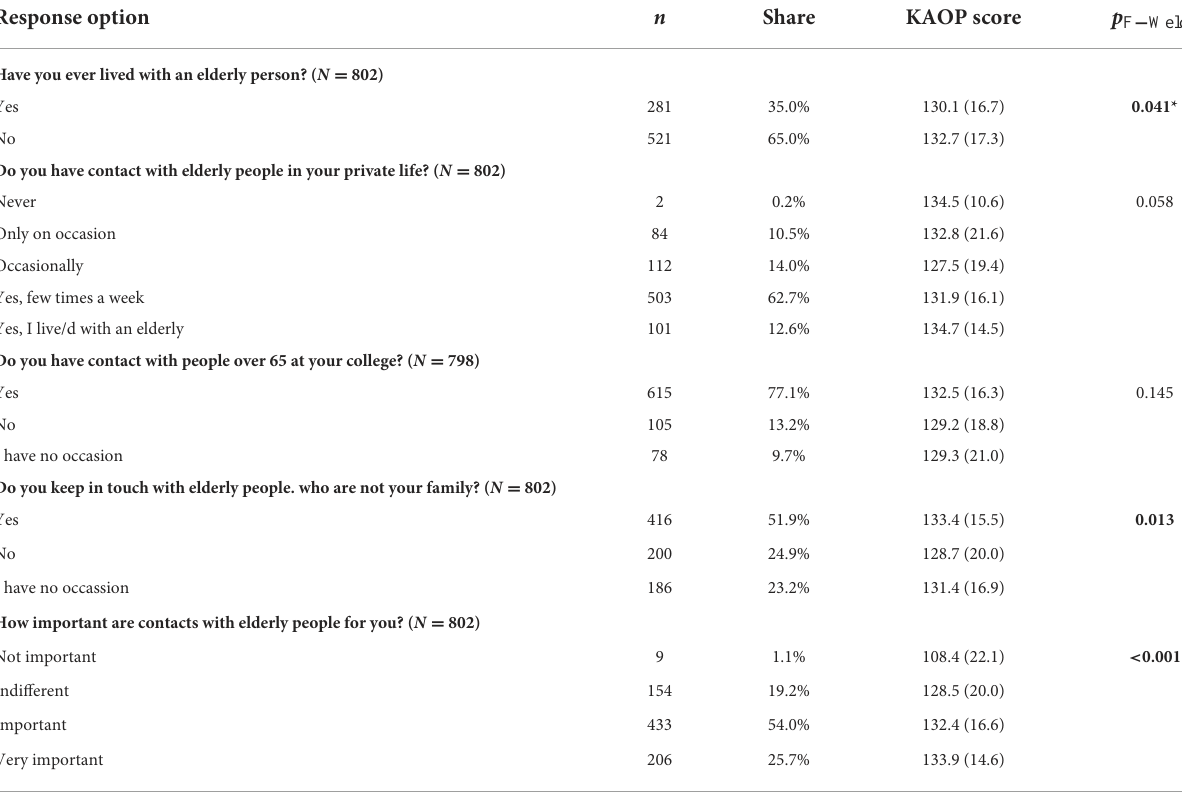
TABLE 8 Survey results with the KAOP questionnaire scores. Response